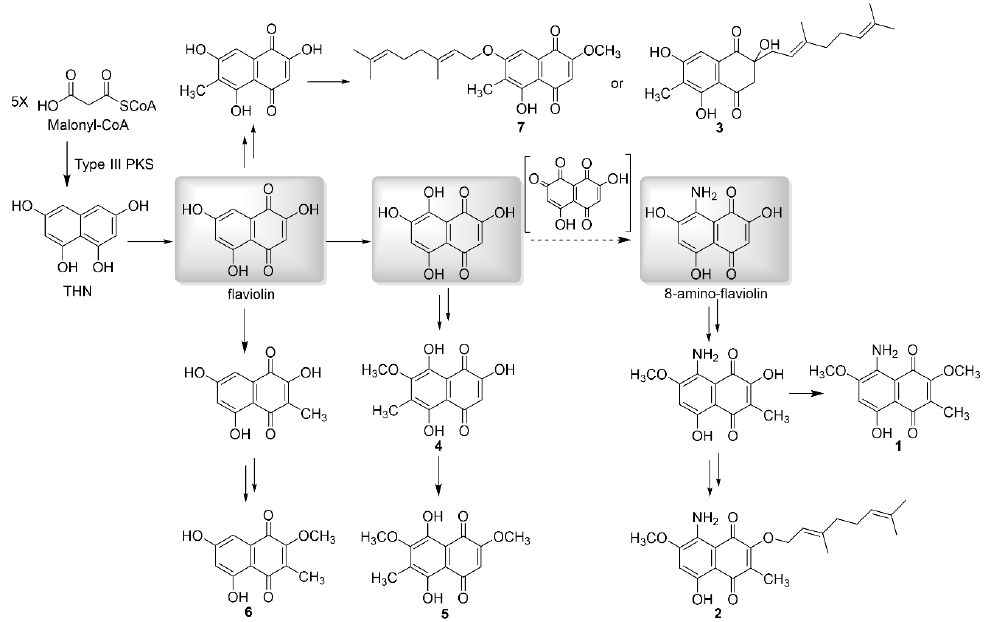
Figure 4. Proposed biosynthetic pathway of flaviogeranins supported by the isolation of isolated flaviogeranin intermediates and congeners. Three common intermediates of the divergent biosynthetic pathway are highlighted in gray.